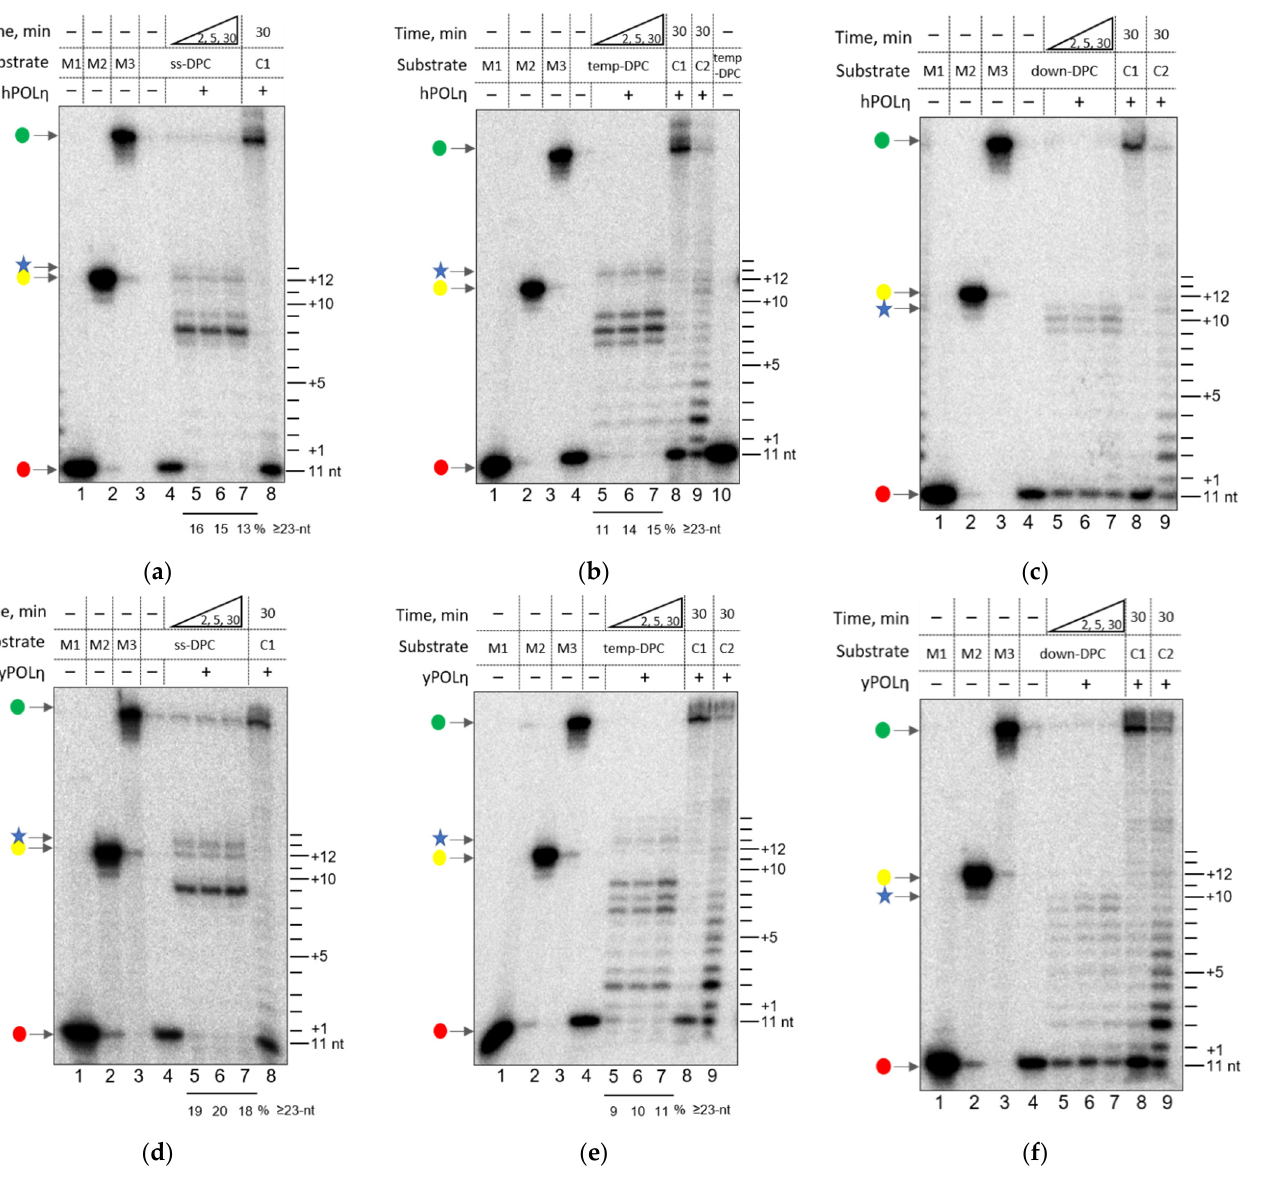
Figure 3. Primer elongation by hPOL η ( a – c ) and yPOL η ( d – f ) encountering a DNA protein cross-link. Panels ( a ) and ( d ), ss-DPC substrate; panels ( b ) and ( e ), temp-DPC substrate; panels ( c ) and ( f ), down-DPC substrate. The red dots mark the primers, the yellow dots correspond to the synthesis until the cross-link site, and the green dots indicate the full-sized products. Lanes 1–3, size markers 11 nt (M1), 23 nt (M2), and 40 nt long (M3); lane 4 (also lane 10 in Panel ( b )), the respective substrate in the absence of DNA polymerase; lanes 5–7, primer extension for 2, 5, and 30 min, respectively; lanes 8–9, primer extension (30 min) on the undamaged primer–template (C1, lane 8) or primer–displaced strand–template substrate (C2, lane 9).